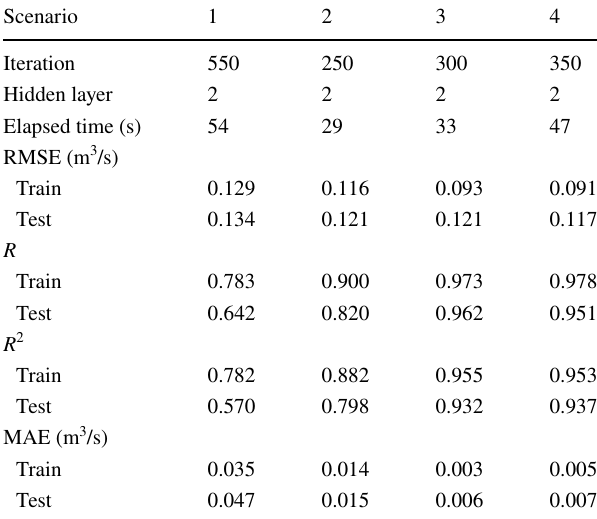
Table 3 Simulations of ANN standalone forecasting model in four